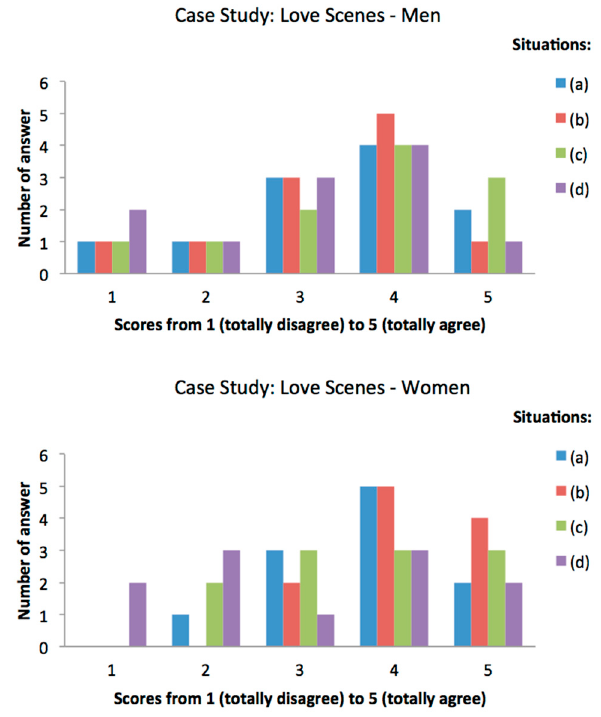
Figure 5. Answers given for the case study of love scenes for men ( top ) and women ( bottom ).